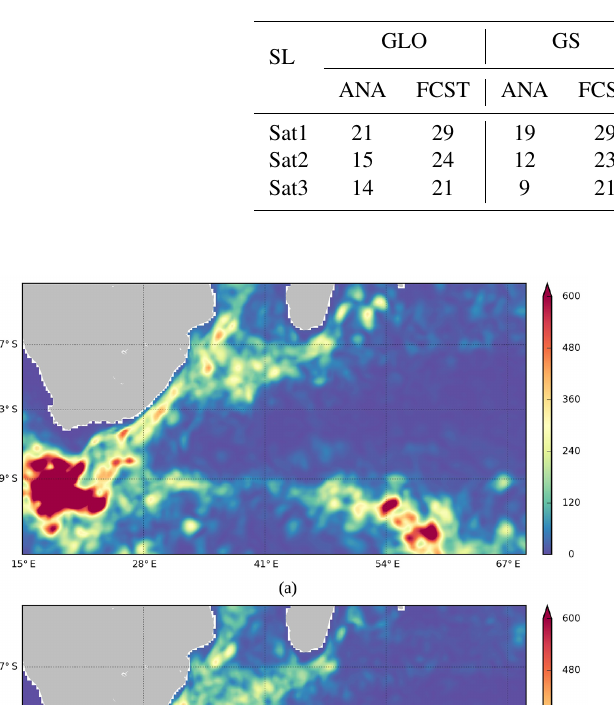
Table 2. Assimilated simulation relative sea level MSE in percent of the free-run MSE.